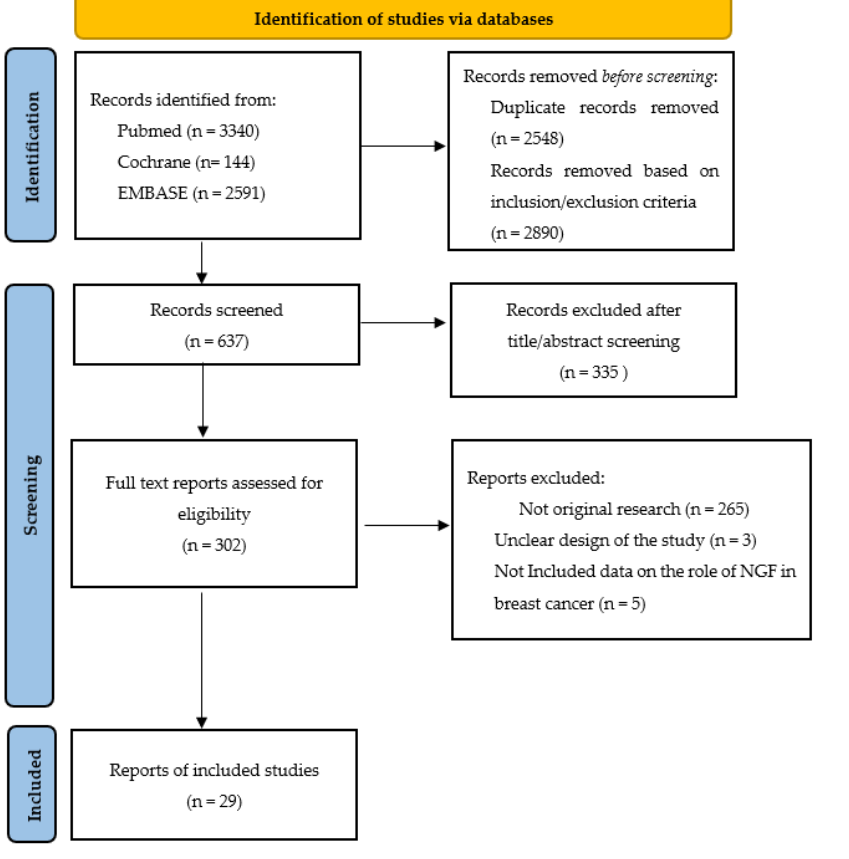
Figure 1. The flowchart of the studies selection. Table 2. Overview of included studies.